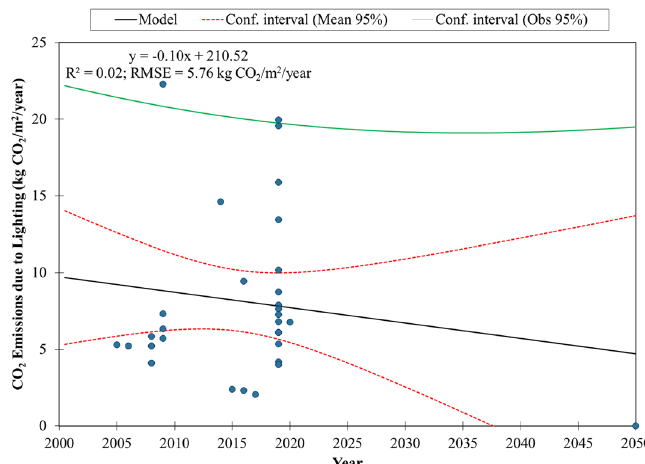
Figure 4. Decarbonisation pathway for lighting by linear regression model for commercial buildings in Southeast Asia with 95% confidence